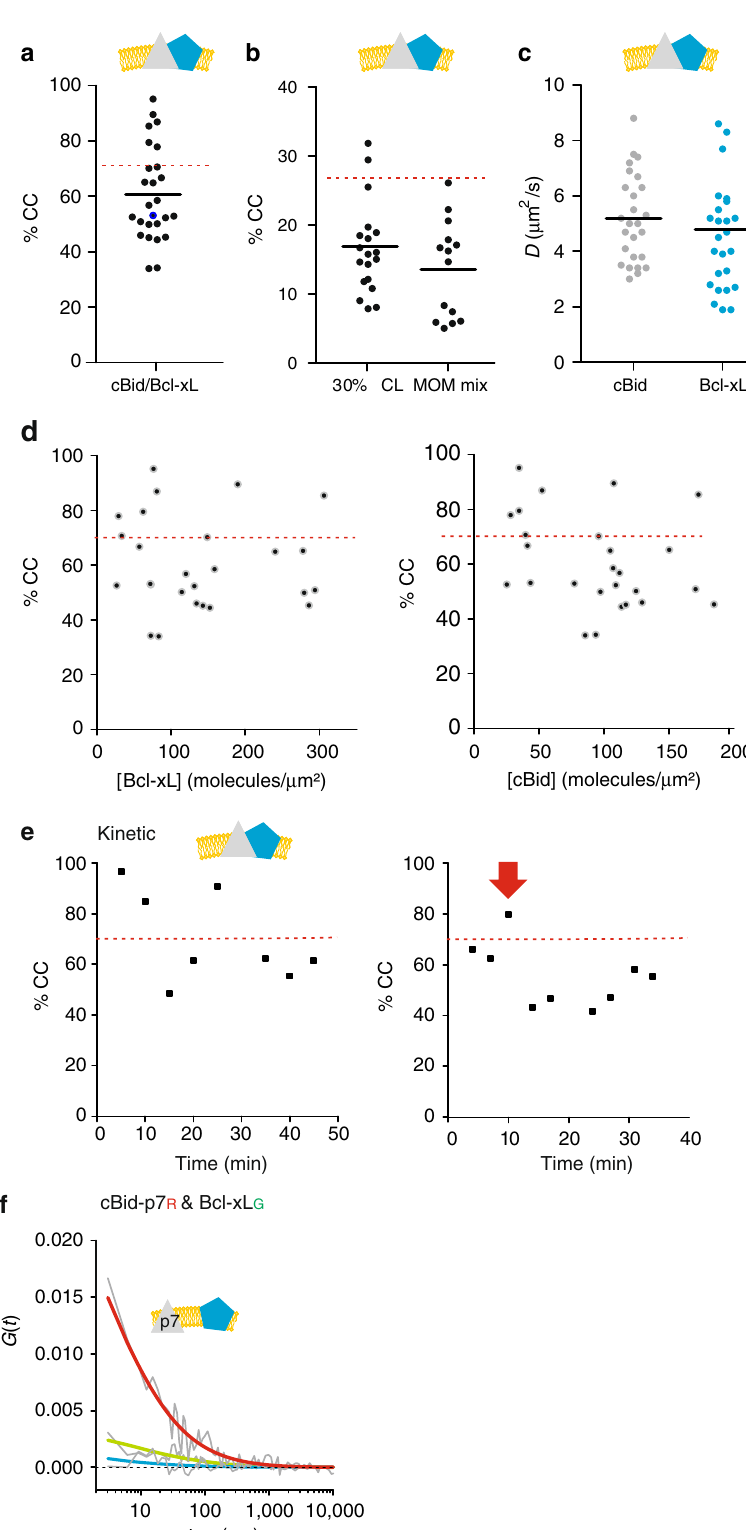
NATURE COMMUNICATIONS | 8: